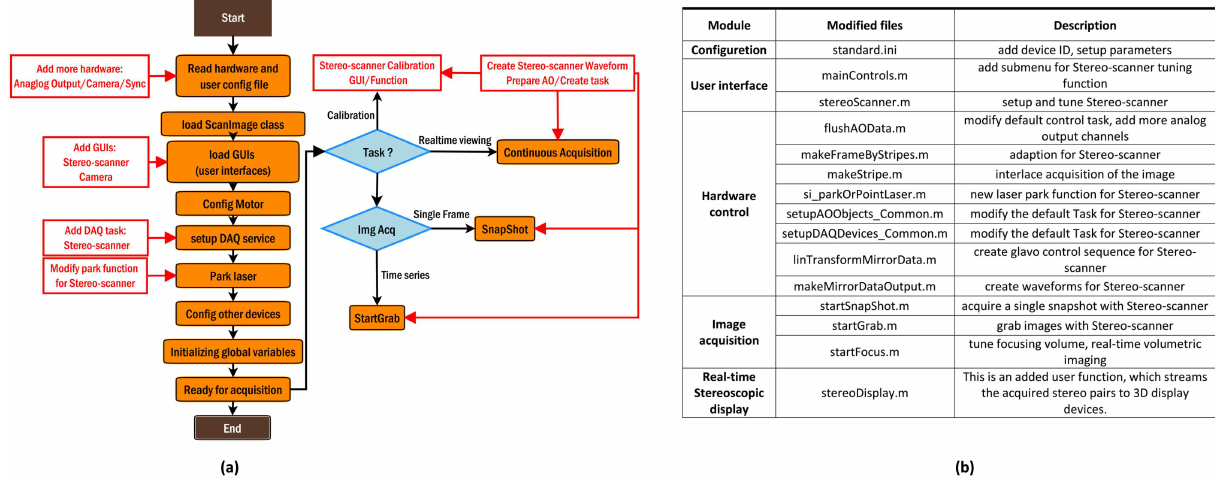
Fig 2. Software control framework based on ScanImage. (a) Modulesmodified(in red boxes) based on ScanImageworkflow (from “Start” to “End”, see [22] for details). (b). List of all the modifiedfiles of